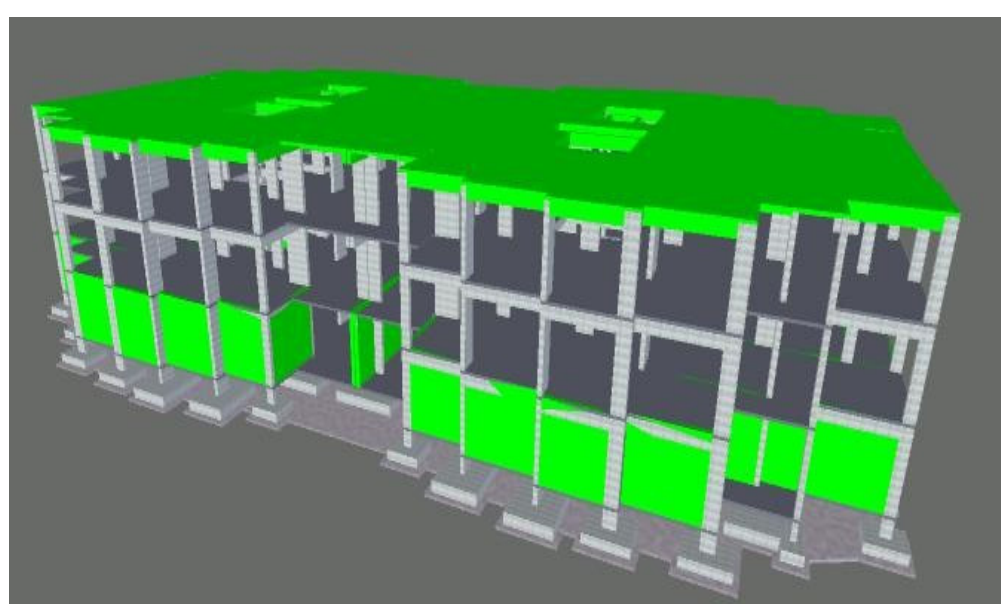
Figure 14. Activities with a DEI of less than 0.80 appeared in yellow during the simulation.